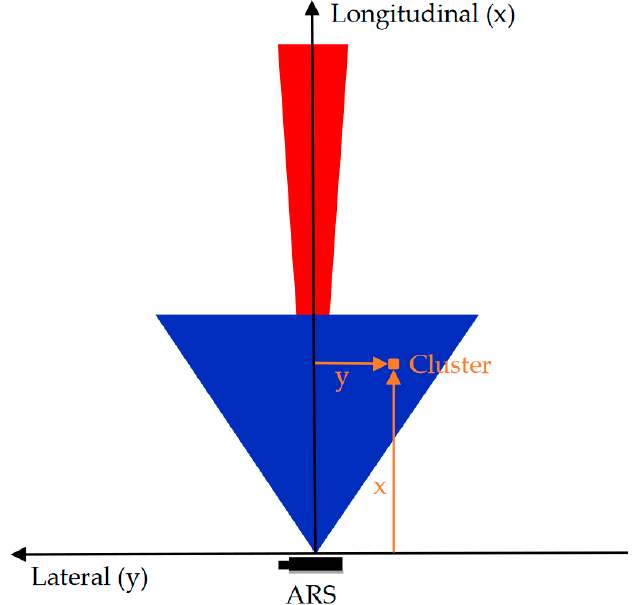
Figure 2. Based on R. Liebske [49] the coordinate system from the radar sensor with one cluster data is described in the longitudinal and lateral axis. In the blue color, the near-field view is represented and in the red, the far-field.